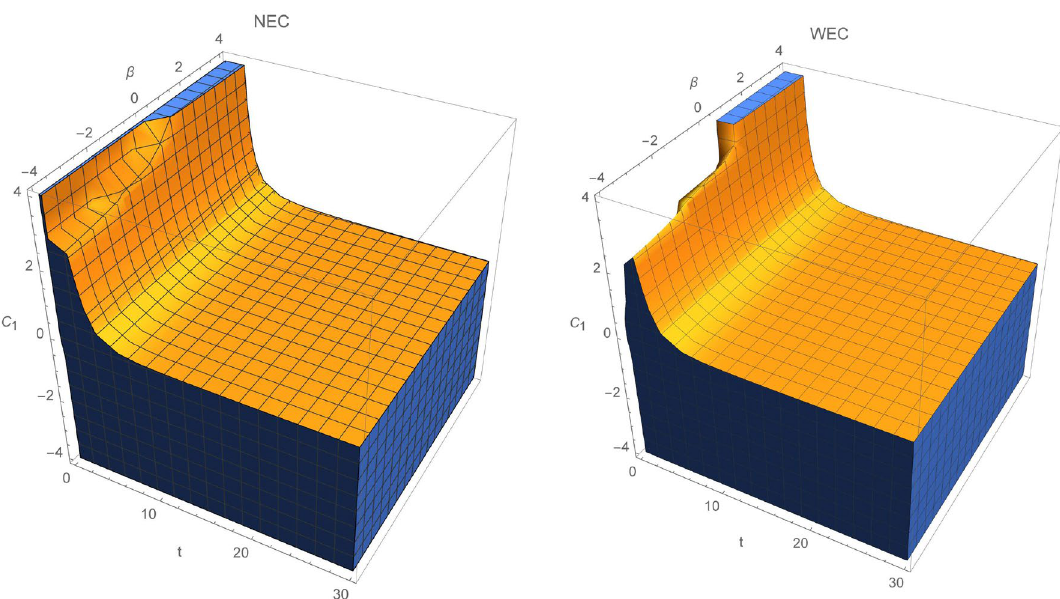
0.2 0.3 and C 3 = =